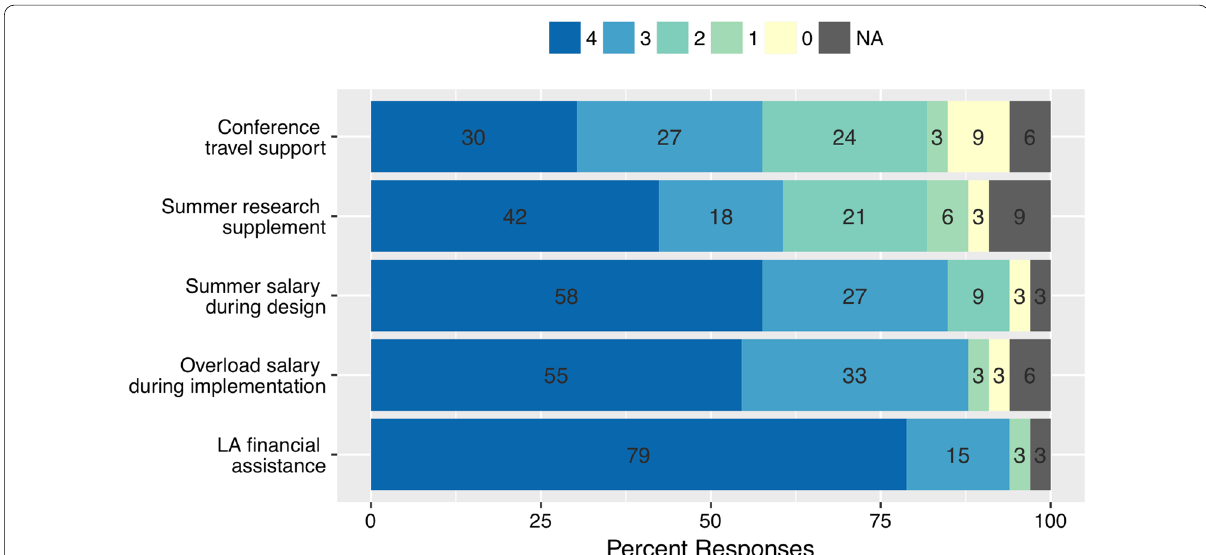
Fig. 4 CISL Program Financial Support. Percent of Faculty Scholars reporting their perceptions on the extent of the benefit of certain programmatic elements that provided financial support. Faculty responses were recorded on an anchored 5-point rating scale, with rating 4 indicating highest agreement (i.e., “very important”) and rating 0 indicating lowest importance (i.e., “not at all important”). Numbers superimposed in the bars are the percentage of respondents choosing that option ( N 33) =